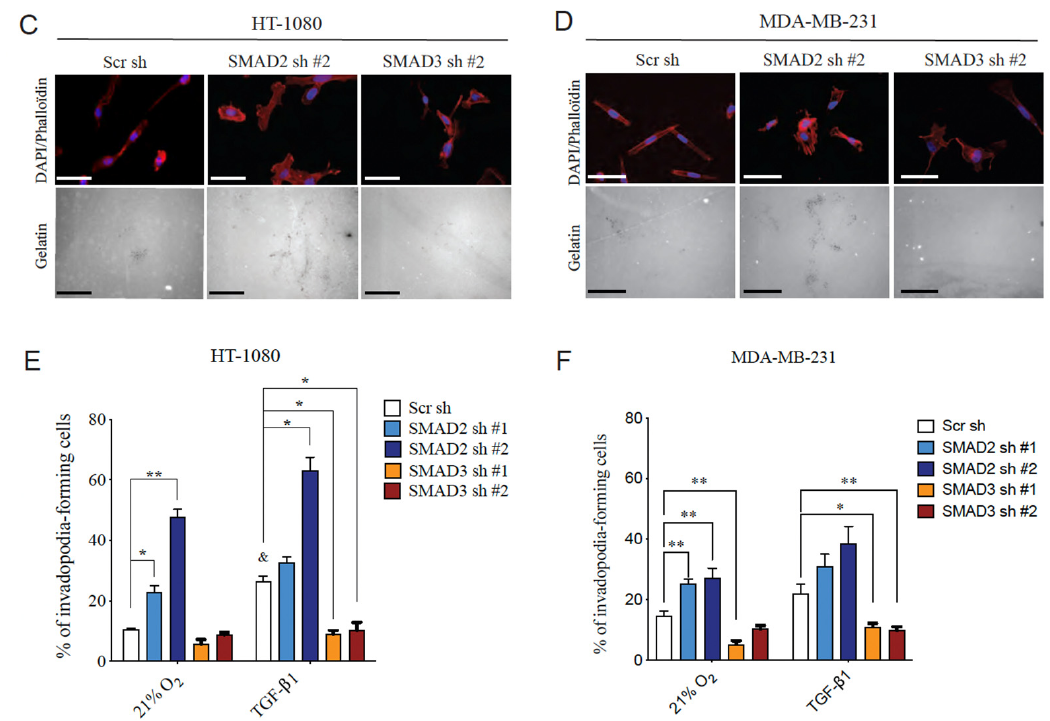
Figure 3. Effect of Silencing the Expression of SMAD2 or SMAD3 on Invasive Properties of Cancer Cells. HT-1080 and MDA-MB-231 cells were transduced with lentiviral shRNA against SMAD2, SMAD3 or a scrambled (Scr) shRNA. ( A , B ) Representative Western blot images of protein expression of SMAD2 and SMAD3 following depletion of SMAD2 or SMAD3 in HT-1080 ( A ) or MDA-MB-231 ( B ) cells. Actin was used as loading control. n = 3. ( C , D ) Representative immunofluorescence images of nucleus (DAPI:blue), actin filaments (phalloidin:red) and gelatin (grayscale) of invadopodia formation by HT-1080 ( E ) and MDA-MB-231 ( F ) cells under normoxic conditions. ( E , F ) Percentage of invadopodia-forming HT-1080 ( E ) and MDA-MB-231 ( F ) cells incubated for 10 h under normoxic (21%O 2 ) or TGF β 1-supplemented (1 ng/mL) conditions ( n = 3–5). Data are presented as mean ± SEM. * p < 0.05 and ** p <